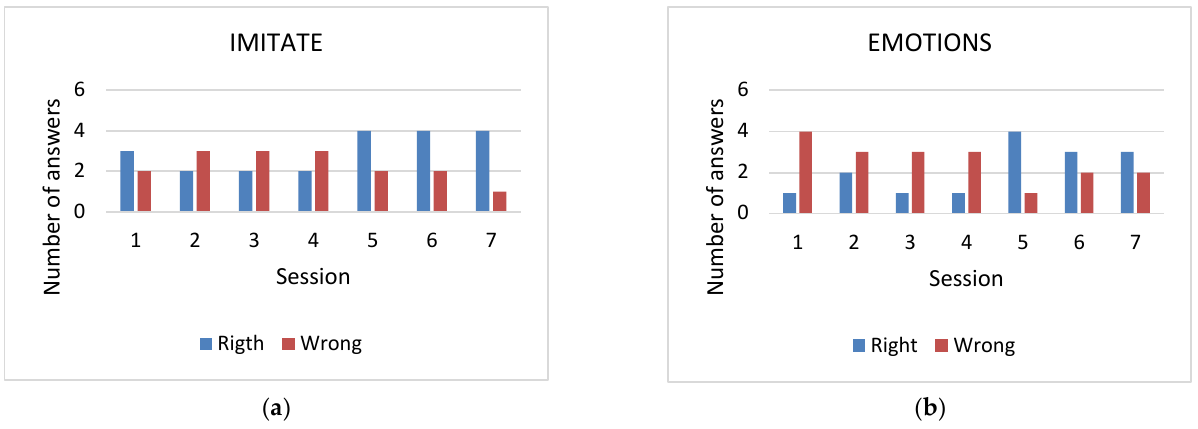
Figure 7. Child B results — On ( a ), the progress over seven sessions with the IMITATE activity. On ( b ), the progress over seven sessions with the EMOTIONS activity.